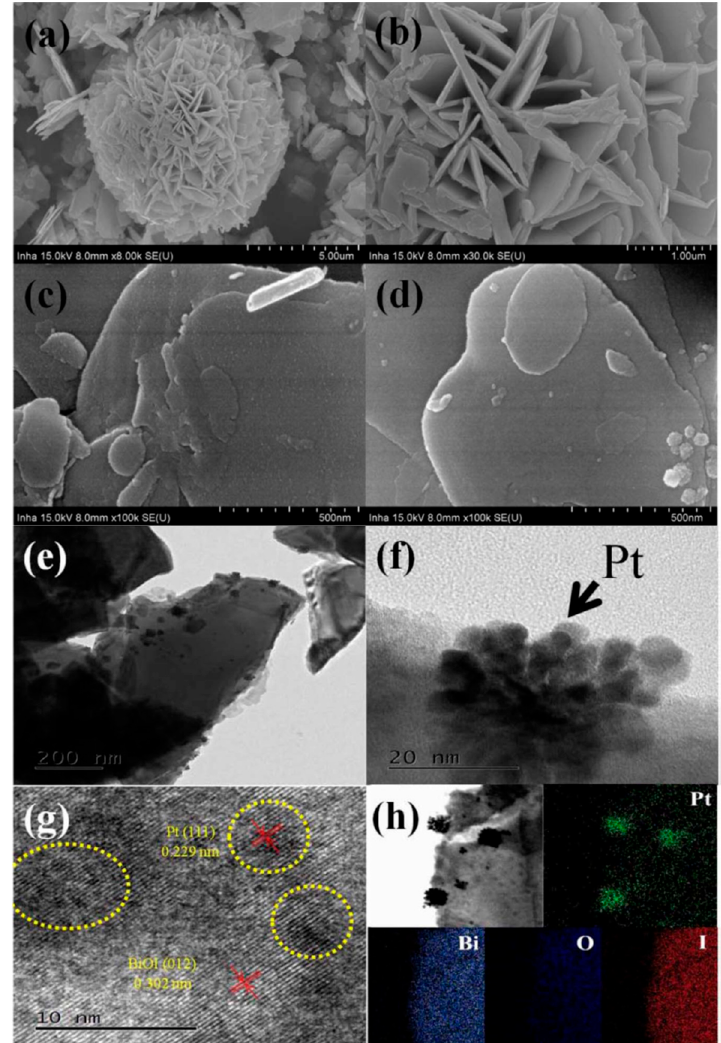
Figure 21. ( a , b ) SEM images of the obtained Pt/BiOI composite nanosheets. ( c , d ) HR-SEM images